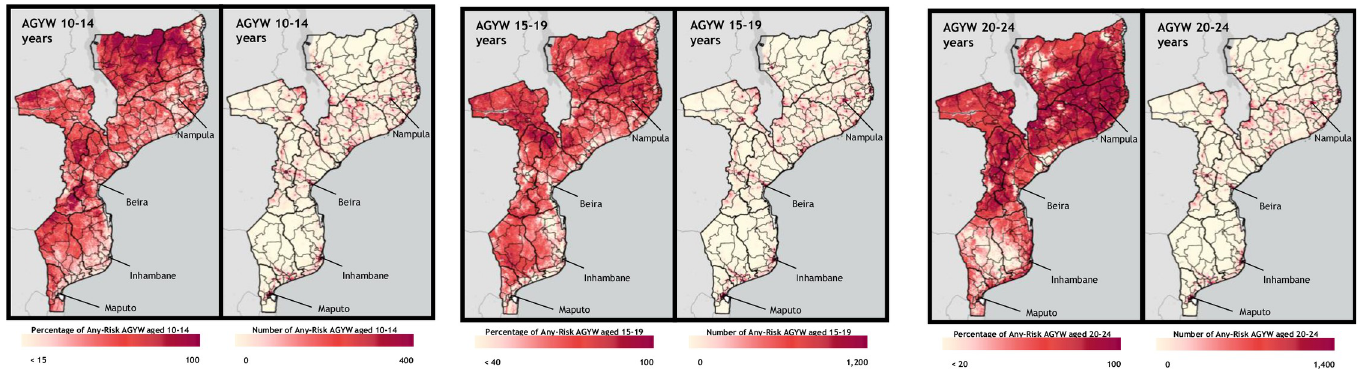
Fig 4. Hyperlocal heat maps of HIV risk prevalence (percentage at risk) and population density (number at risk), based on any-risk profile in Mozambique, by age band. The number-at-risk is calculated as those AGYW who are both classified as at-risk and HIV-negative for AGYW ages 15+, and the number-at-risk for AGYW 10–14 years is calculated as those AGYW classified as at-risk. Base map and data from the Spatial Data Repository, The Demographic and Health Surveys Program.